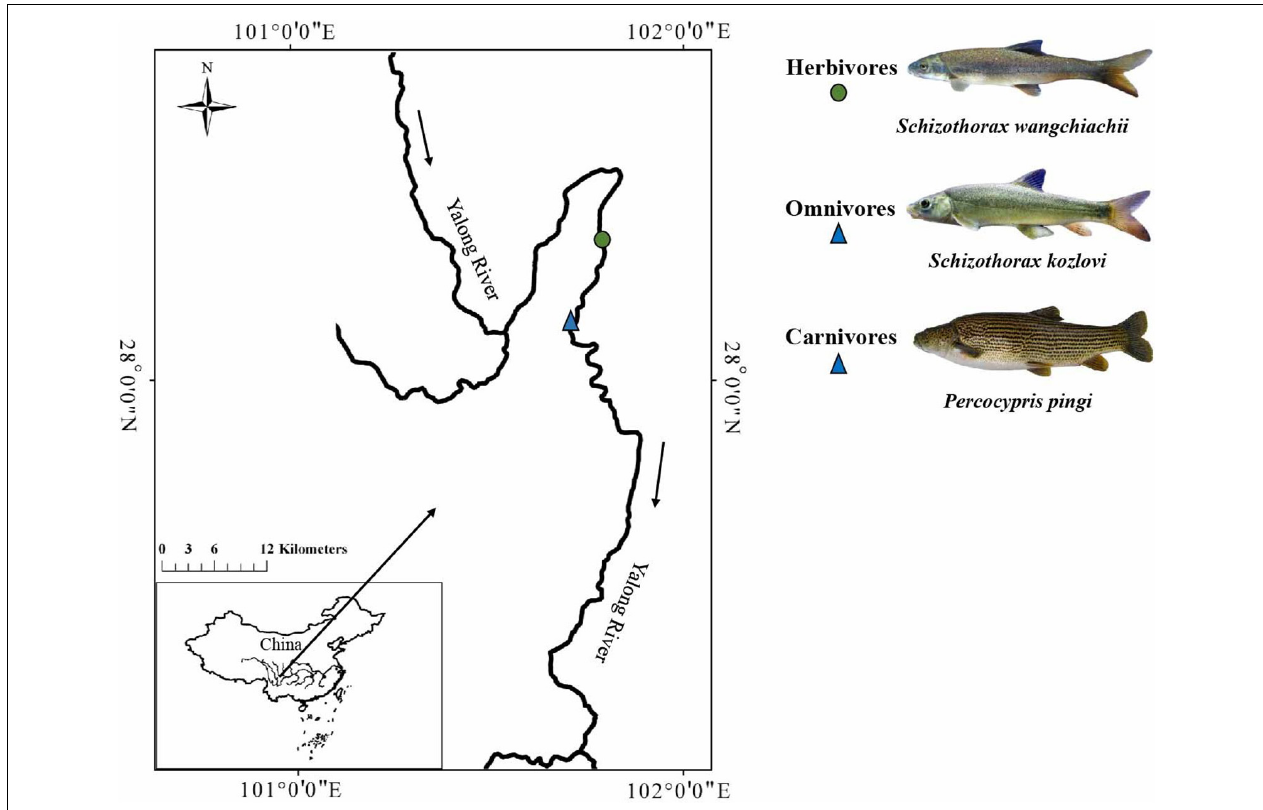
FIGURE 1 | Sampling sites of the three cold-water fishes investigated. The solid circle represents the sampling sites for herbivores, and the solid triangle represents the sampling sites for omnivores and